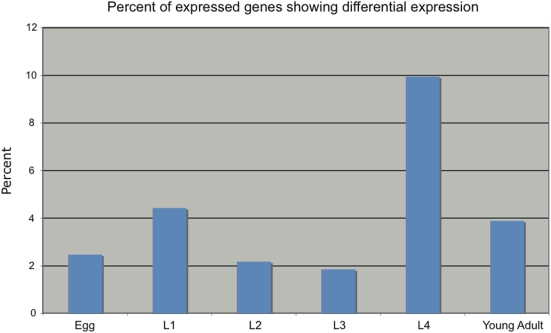
The L4 stage displays the largest variation in expression levels between strains.Each stage was analyzed separately. The dataset was filtered for genes that are present in all of the arrays for each stage. The number of expressed genes is different for each time point. A one-way ANOVA was used to identify genes that varied by strain; p-values of less than .01 were called significant.